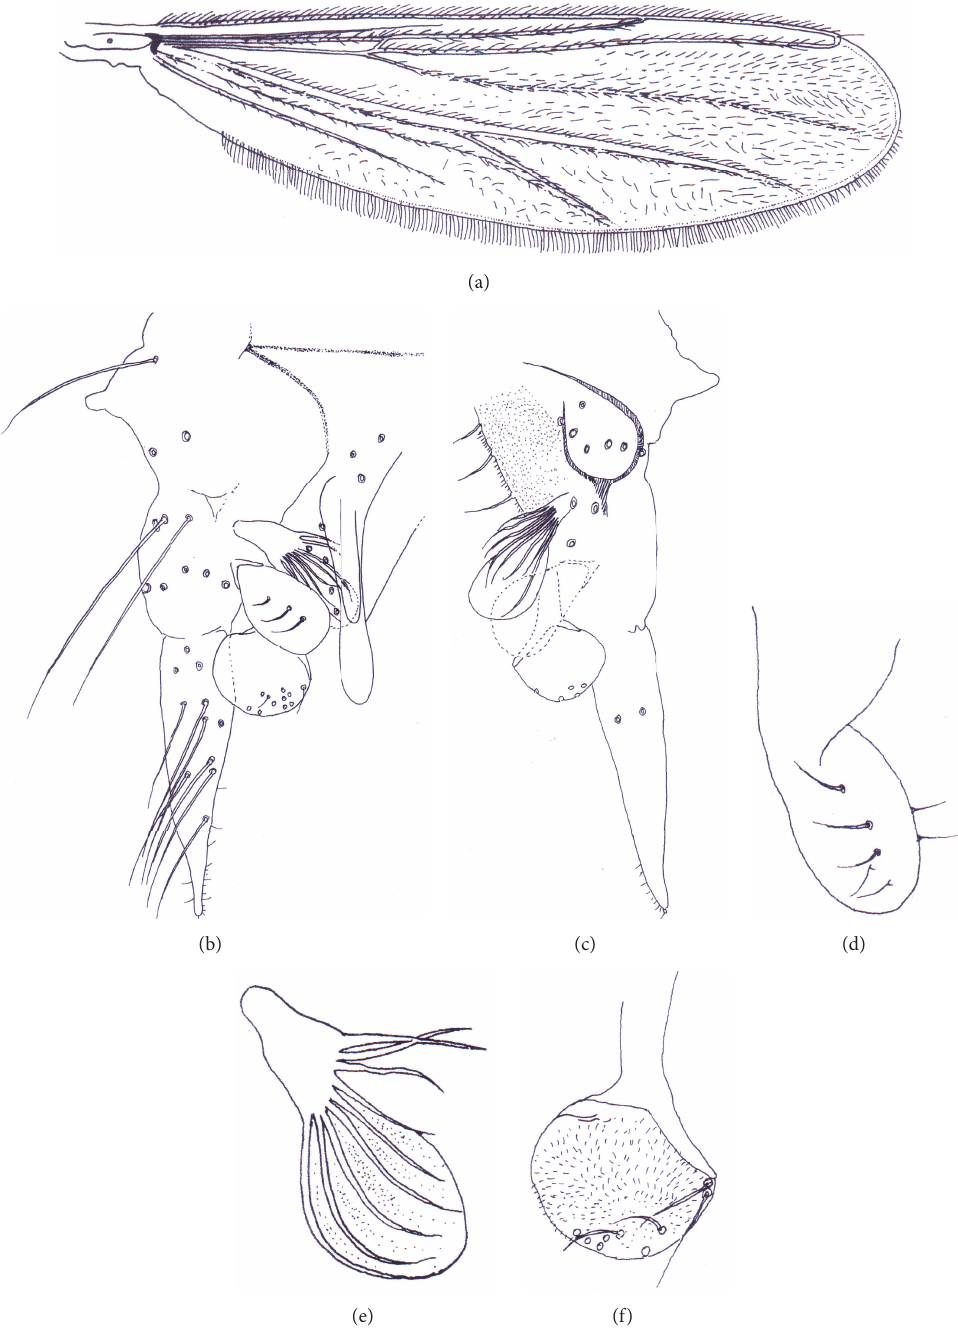
Figure 3: Rheotanytarsus spinicornus n. sp., adult male: (a) wing; (b) hypopygium (left-dorsal view); (c) hypopygium (right-ventral view); (d) superior volsella; (e) median volsella; (f) inferior volsella.